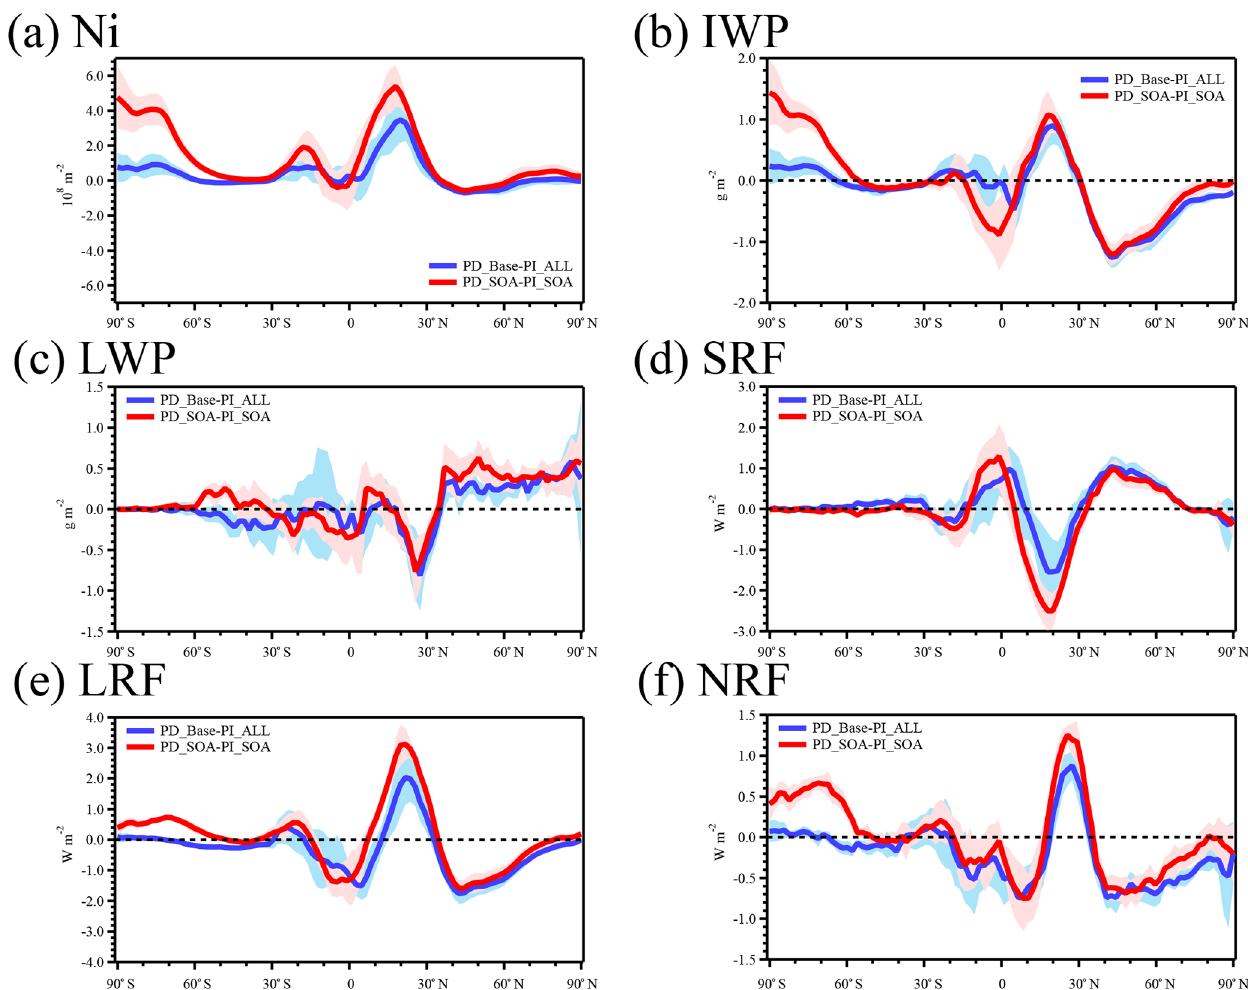
Figure 13. Change in vertically integrated ice number concentration (a) , ice water path (b) , liquid water path (c) , and shortwave radiative forcing (d) , longwave radiative forcing (e) , and all-sky net radiative forcing (f) for the difference between the PD_SOA and PI_SOA cases (red line) as well as the PD_Base and PI_ALL cases (blue line). The shading represents 1 standard deviation of the interannual variation over 6